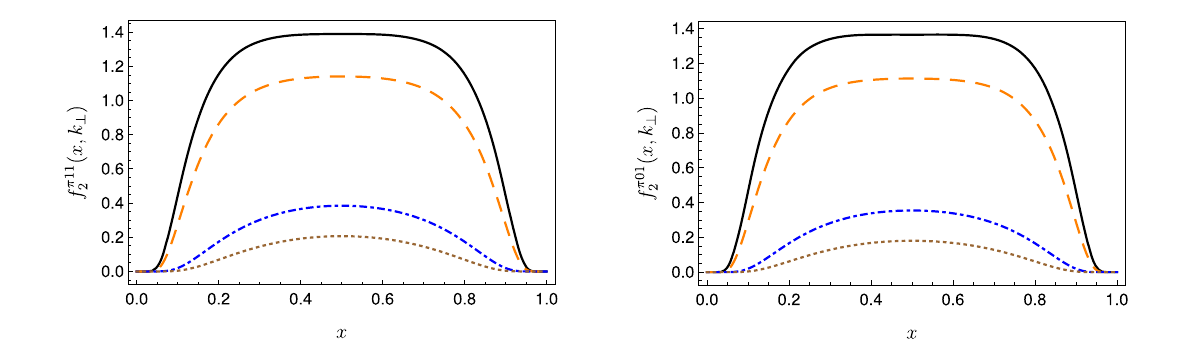
Fig. 2 Left panel: dPDFs evaluated within the original model [34] and addressed for different values of k ⊥ . Full black line k ⊥ = 0 GeV, dashed orange line k ⊥ = 0 . 2 GeV, dot-dashed blue line k ⊥ = 0 . 5 GeV and dotted brown line k ⊥ = 0 . 6 GeV. Right panel: same of the left panel for the ratio Eq. (7)